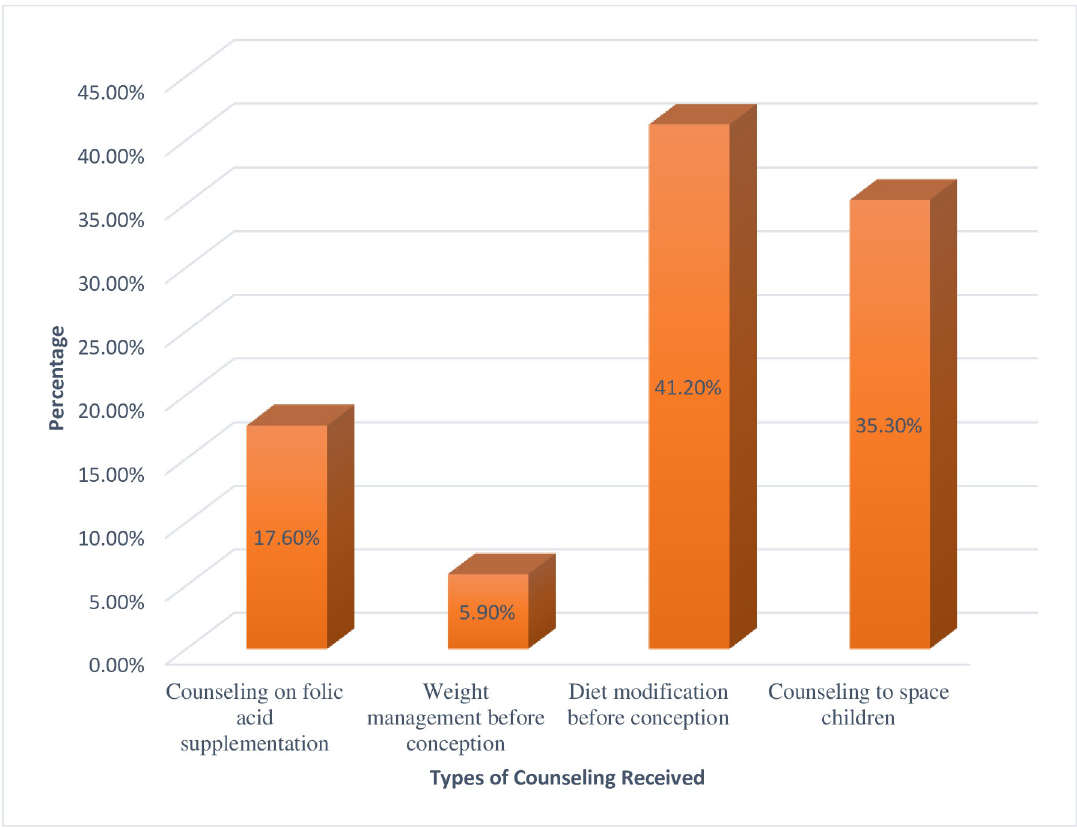
Fig 1. Types of counseling received on preconception care among women attending antenatal care clinics of public health facilities in Hossana town, Southern Ethiopia, 2020.